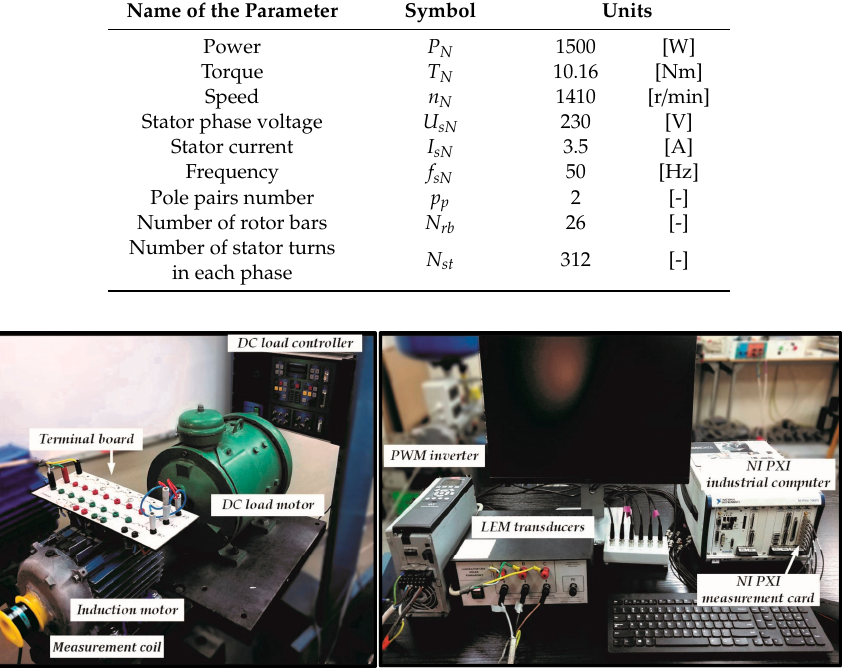
Figure 6. Real view of the experimental set-up.